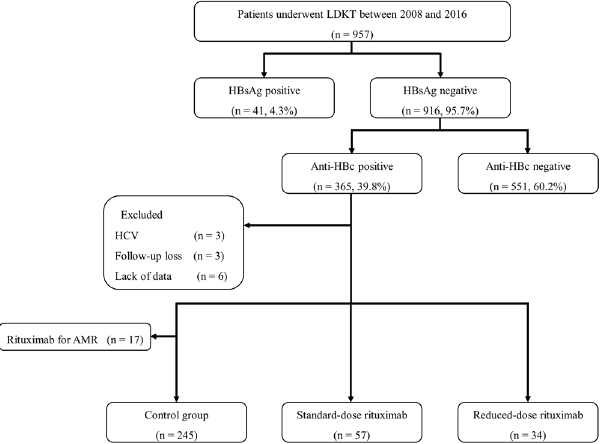
Figure 1. Study design.